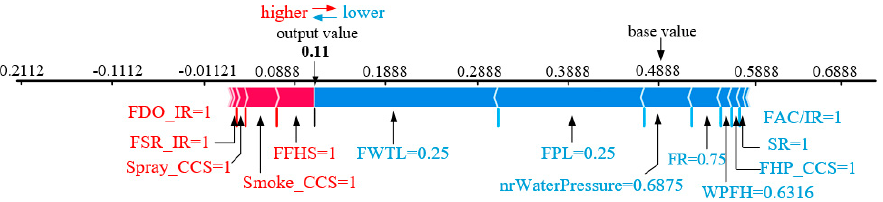
Figure 10. Explanation of the Ideal Safety mode.